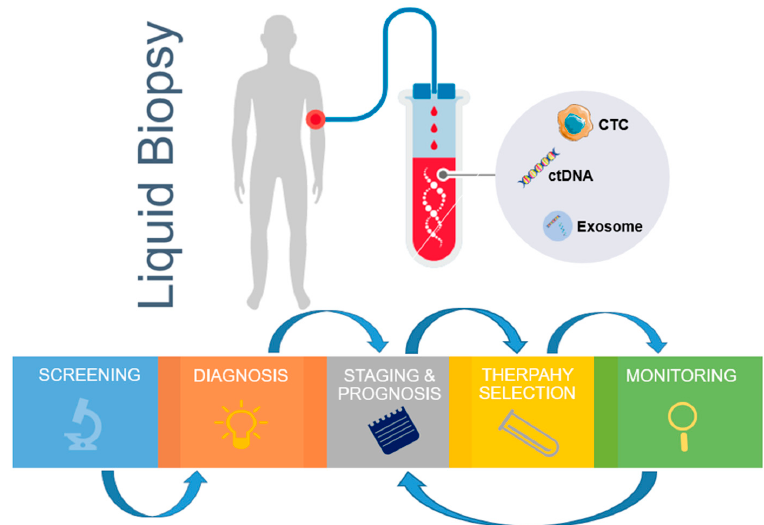
Figure 1. Clinical applications of liquid biopsy from blood circulating markers. The genomics and immunology information derived from liquid biopsy samples can be used for continuous monitoring, from early stage disease screening, assistance diagnosis, personalized therapy selection, to recurrence monitoring. CTC—circulating tumor cells; ctDNA—circulating tumor DNA.